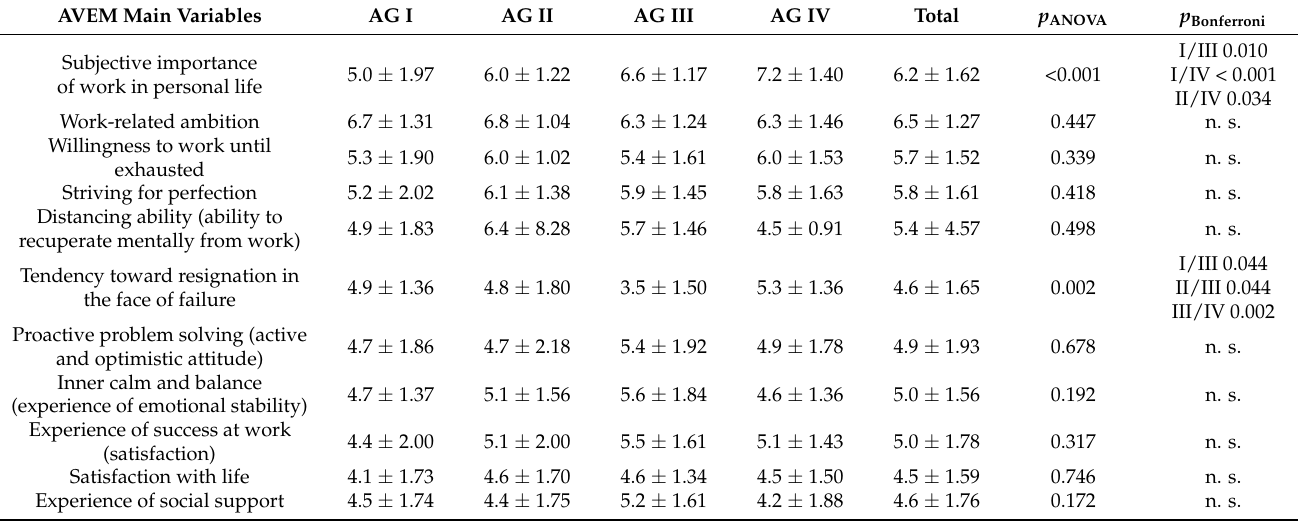
Table 3. Characteristics of AVEM dimensions taking into account age groups (Stanine M ± SD = mean and standard deviation).